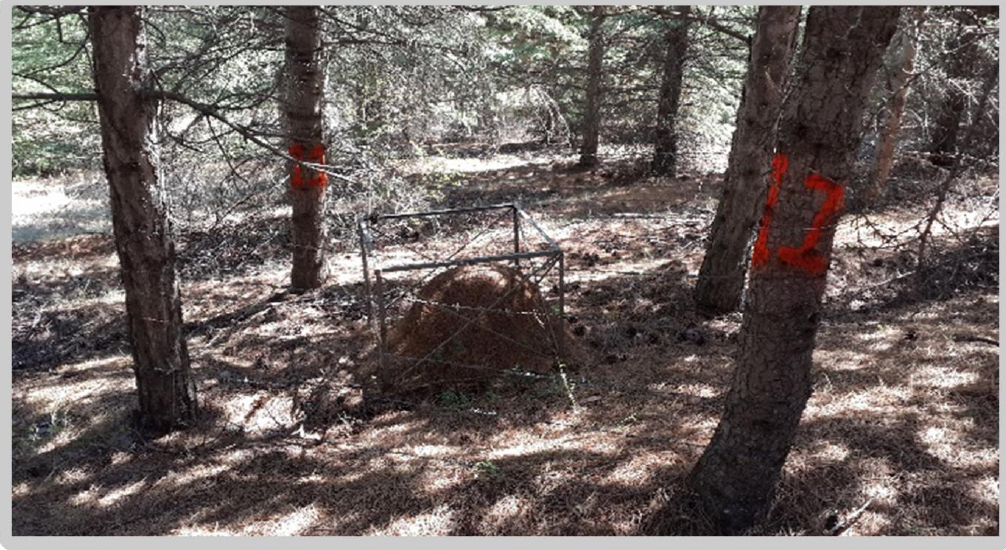
Figure 2. Transplanted Formica rufa nest with a protective cage in Isparta, Turkey (transplanted in 2012, photographed in 2016).